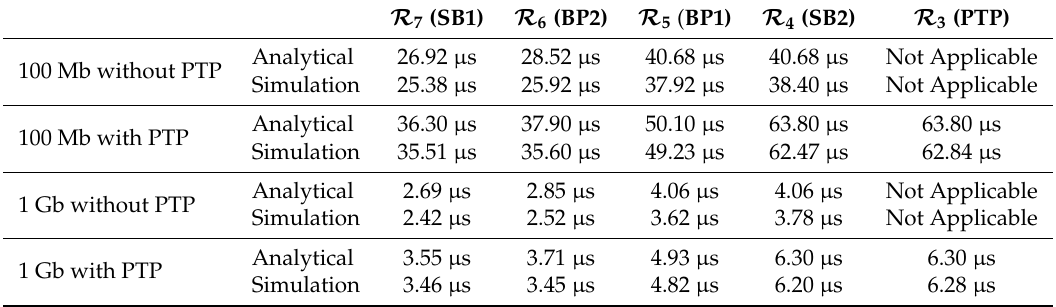
Table 11. Results of a T1-1 system with 100 Mbps and 1 Gbps links both with and without PTP